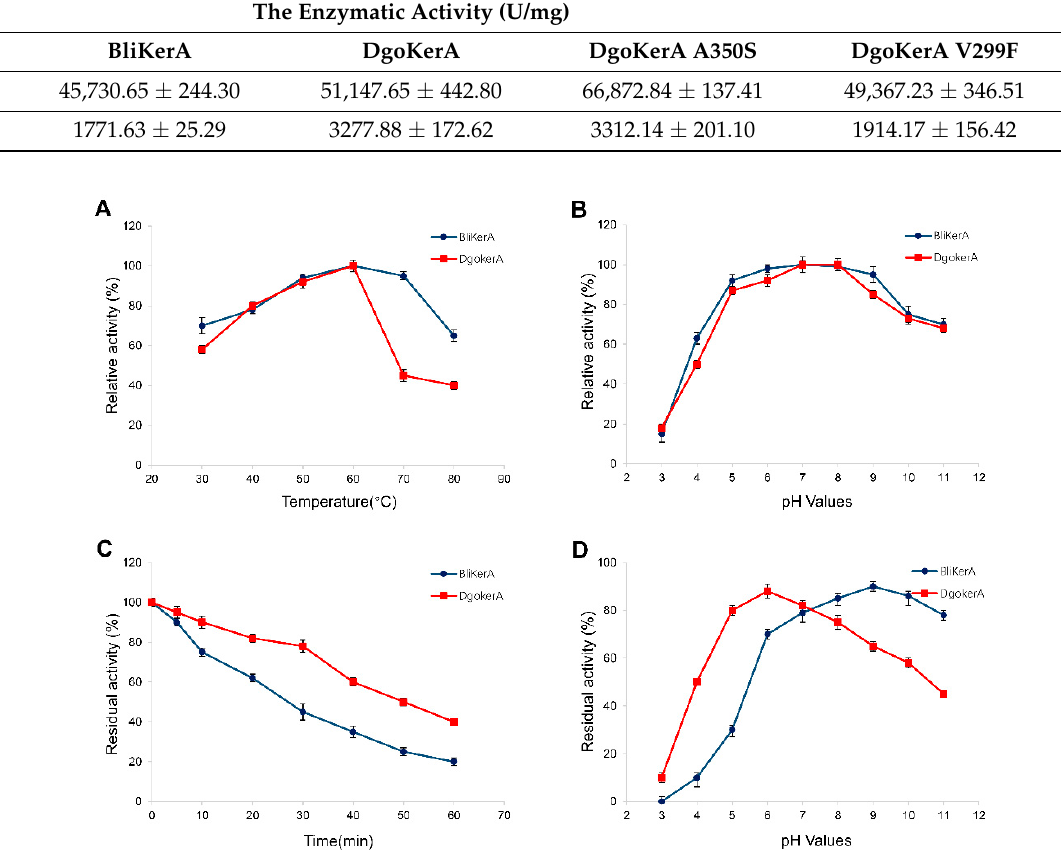
Figure 4. Effects of temperature and pH on keratinase activity. ( A ) effects of temperature for Dgo- KerA and BliKerA; ( B ) effects of pH for DgoKerA and BliKerA; ( C ) the thermostability of keratinase; ( D ) the pH stability of keratinase.